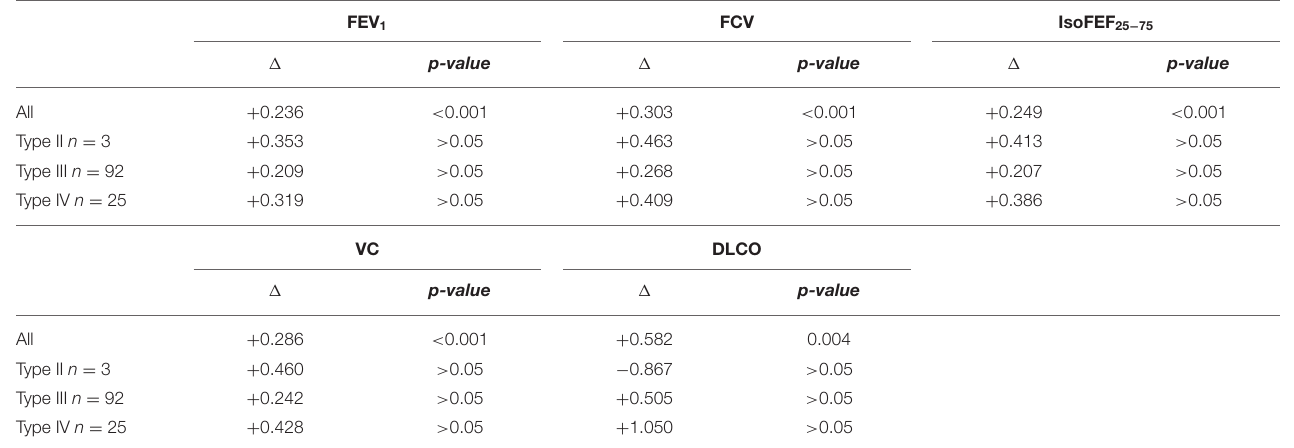
TABLE 3 | Spirometry values stratified by hiatal hernia classification Carrott et al. (9) n =